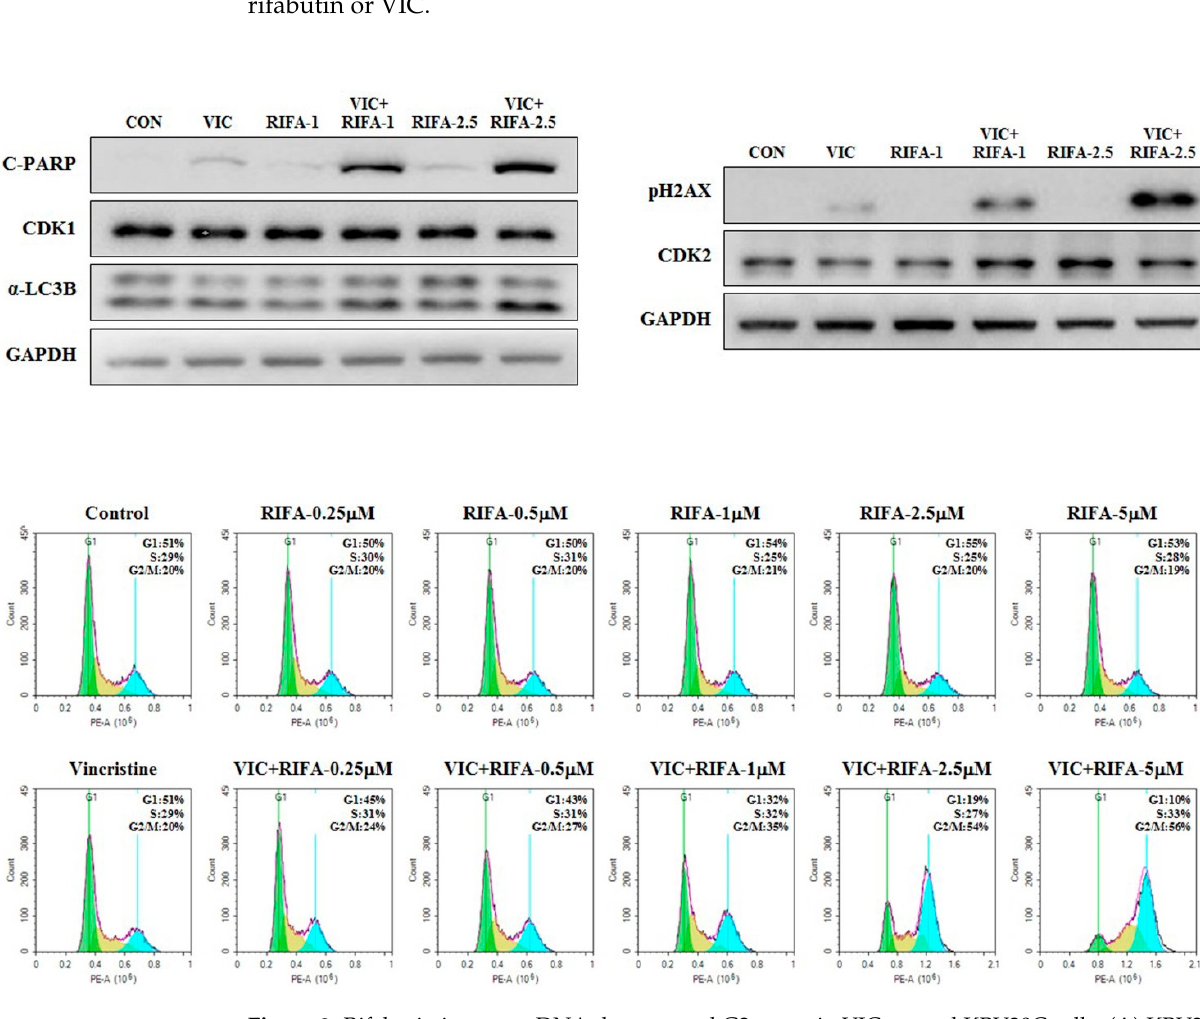
Figure 3. Rifabutin increases DNA damage and G2 arrest in VIC-treated KBV20C cells. ( A ) KBV20C cells were treated with 5 nM vincristine (VIC), 1 µ M rifabutin (RIFA-1), 2.5 µ M rifabutin (RIFA-2.5), 5 nM VIC with 1 µ M rifabutin (VIC + RIFA-1), 5 nM VIC with 2.5 µ M rifabutin (VIC + RIFA-2.5), or 0.1% DMSO (CON). After 24 h, Western blot analysis was performed using antibodies against C-PARP, CDK1, α -LC3B, pH2AX, CDK2, and GAPDH. ( B ) KBV20C cells were treated with 5 nM VIC, the indicated concentration ( µ M) of rifabutin (RIFA) alone, or in combination with 5 nM VIC, or 0.1% DMSO (Control). After 24 h, FACS analyses were performed as described in Section 4: Materials and